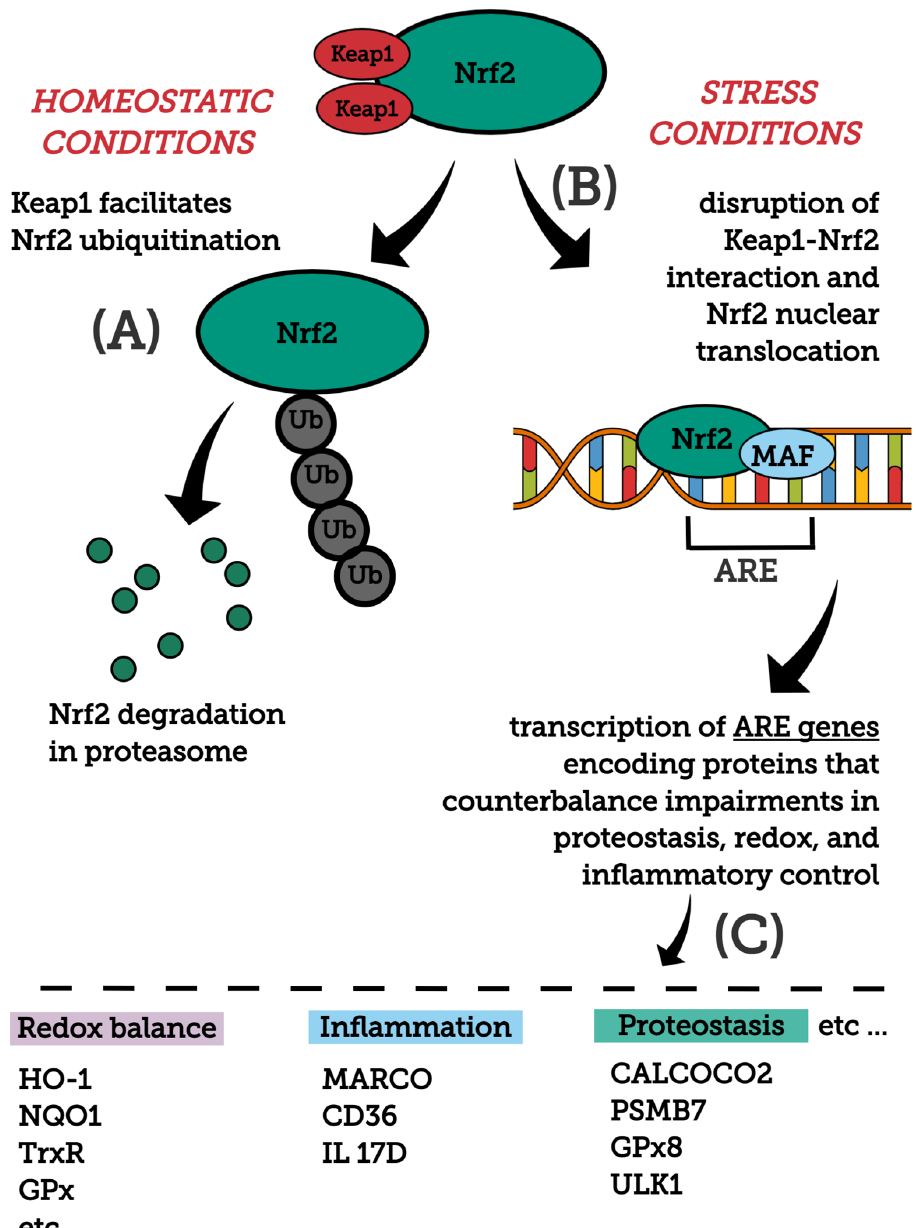
Figure 1. General overview of the Nrf2 pathway. Major molecules and events modulating Nrf2 stability and activation, as well as main downstream protein targets and their functions are shown. ( A ) Nrf2 structure is composed by domains (i.e., Neh2 and Neh6) that, after redox or signaling regulation, affect Nrf2 stability. Under homeostatic conditions, Keap1 binds to Nrf2, directing this transcription factor to ubiquitination and subsequent degradation by the proteasome. Keap1 is a redox sensor that, upon oxidative thiol modification, loses its capability to repress Nrf2. Glycogen synthase kinase 3 (GSK- 3)-mediated phosphorylation of Nrf2 represents an alternative mechanism, facilitating its ubiquitination and consequent degradation by the proteasome. ( B ) Under stress conditions (excessive accumulation of ROS, electrophilic molecules and proteotoxic stress), Nrf2-Keap1 interaction is disrupted and Nrf2 translocates into the nucleus, wherein it heterodimerizes with small Maf proteins (sMaf) and binds to an enhancer sequence termed ARE that is present in the regulatory regions of over 250 genes (ARE genes). ( C ) These ARE genes, whose encoded proteins participate in diverse cellular/metabolic events, display significant roles in counteracting imbalances in proteostasis, redox and inflammatory control. For a detailed review on the mechanisms mediating Nrf2 stability and activation, see [74]. CALCOCO2, calcium binding and coiled-coil domain 2; CD36, CD36 scavenger receptor; GPx, glutathione peroxidase; Gpx8, glutathione peroxidase 8; HO-1, heme oxygenase-1; IL 17D, interleukin-17D; NQO1, NADPH Quinone oxidoreductase enzyme; PSMB7, proteasome subunit b type-7; TrxR, thioredoxin reductase; ULK1, unc-51 like autophagy activating kinase